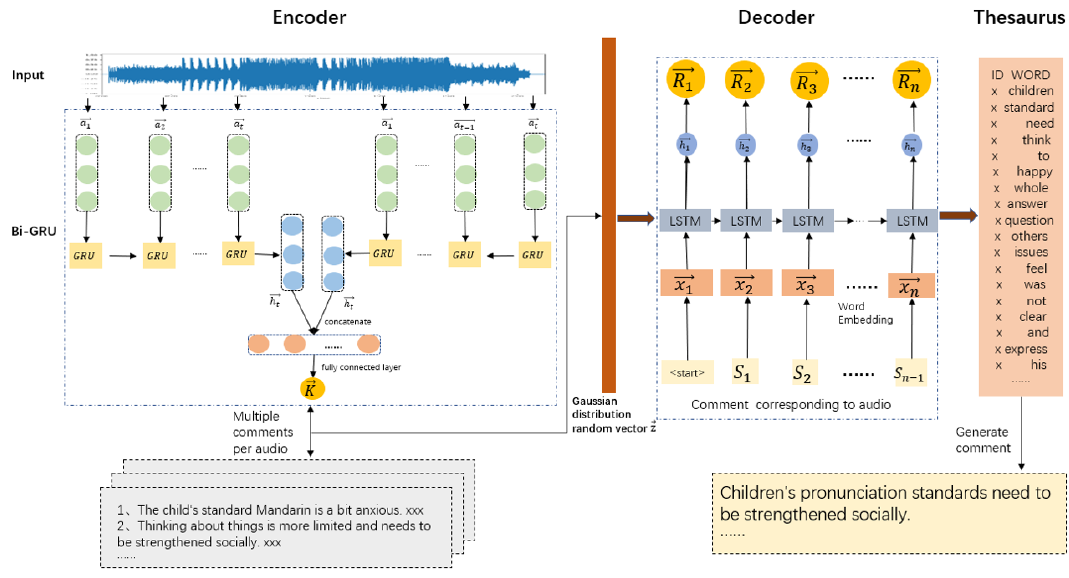
Figure 2. Neural Audio Caption Model. The encoder of the model encodes the MFCC feature